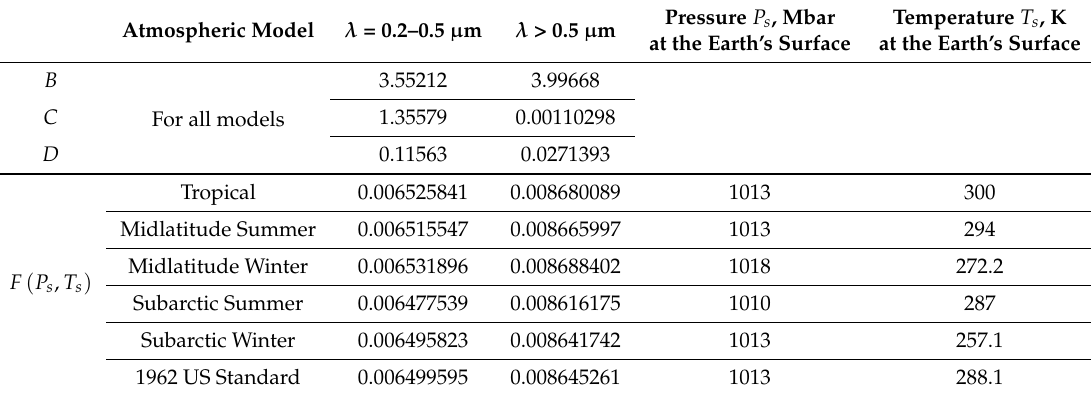
Table 1. Values of coefficients for calculating the Rayleigh optical thickness of the total atmosphere from Equation